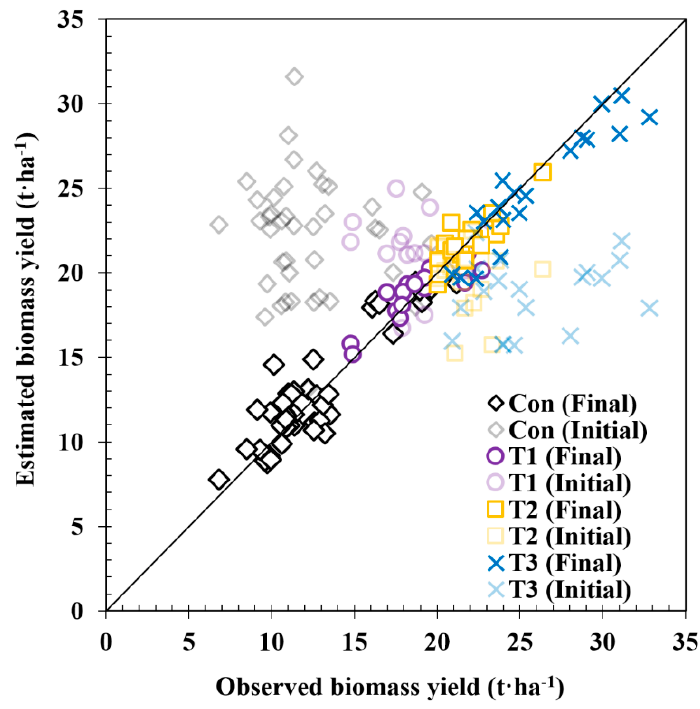
Figure 3. Goodness-of-fit plots with 1:1 line comparing the estimated and simulated Napier grass DMY values with parameters before and after calibration under different N-fertilizer levels, where controlled, treatment 1, treatment 2, and treatment 3 represent N-fertilizer levels of 0, 125, 250, and 500 kg·ha − 1 , respectively. Table 3. Parameter setting for Napier grass in the SWAT model crop file, and the RMSE of yield by initial and final values after calibration.